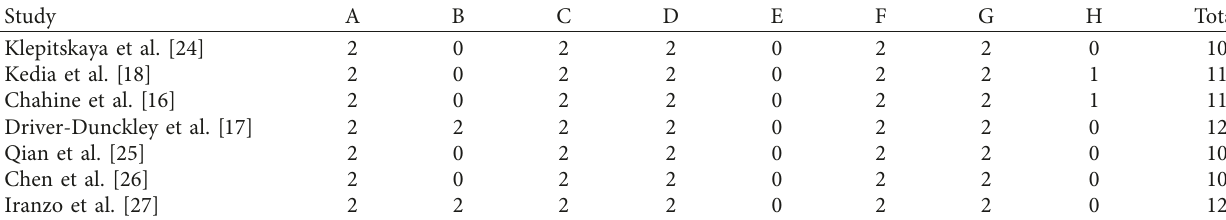
Table 2: MINORS scores of eligible studies.